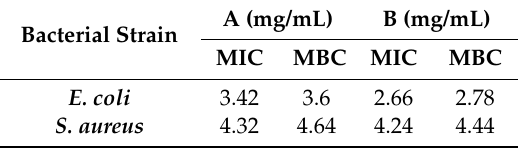
Table 3. MIC and MBC values of the compounds A and